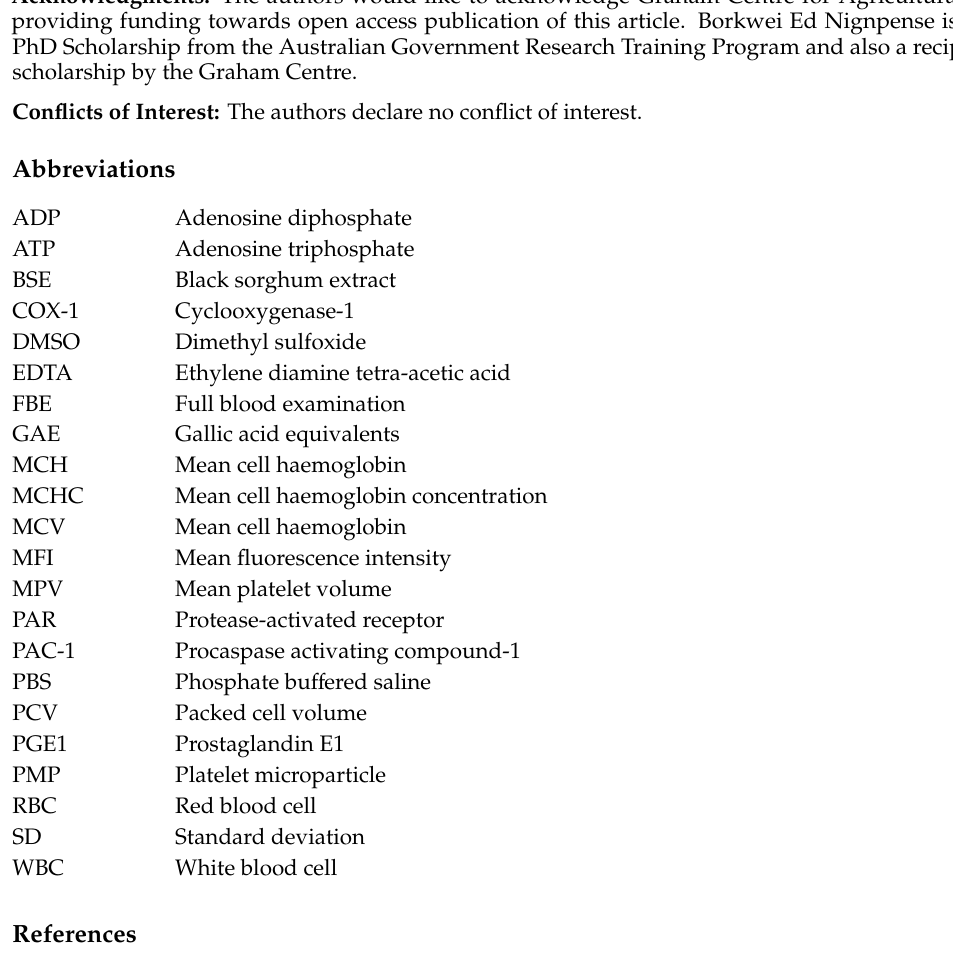
and data is represented in mean fluorescence intensity (MFI) versus BSE concentrations Error bars expressed as mean ± SD, Table S1: Phenolic composition and antioxidant activity of sorghum varieties on as is basis, Table S2: List of top ten phenolic compounds identified in the black sorghum phenolic rich extracts by Q-TOF LC / MS